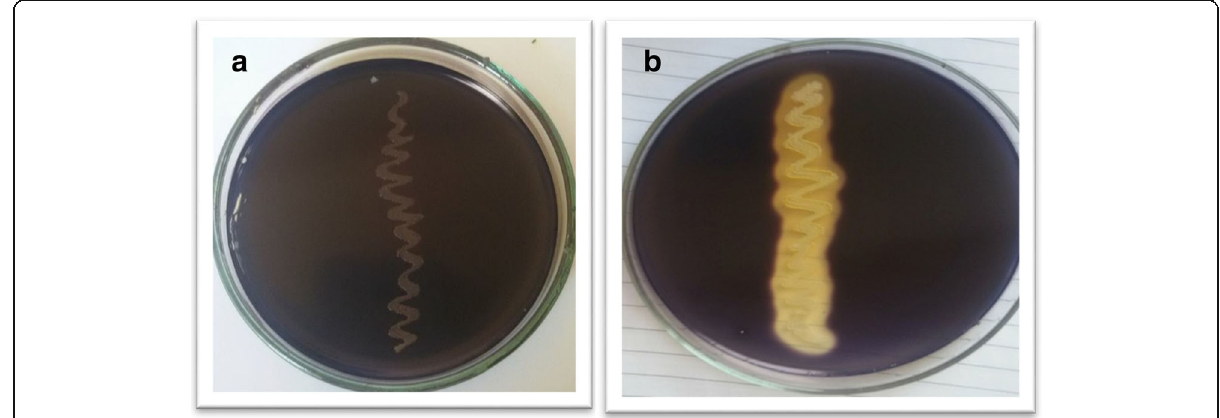
Fig. 1 Bacterial isolate negative for starch hydrolysis test ( a ). Zone of clearance around NRC22017 ( b ) due to starch hydrolysis